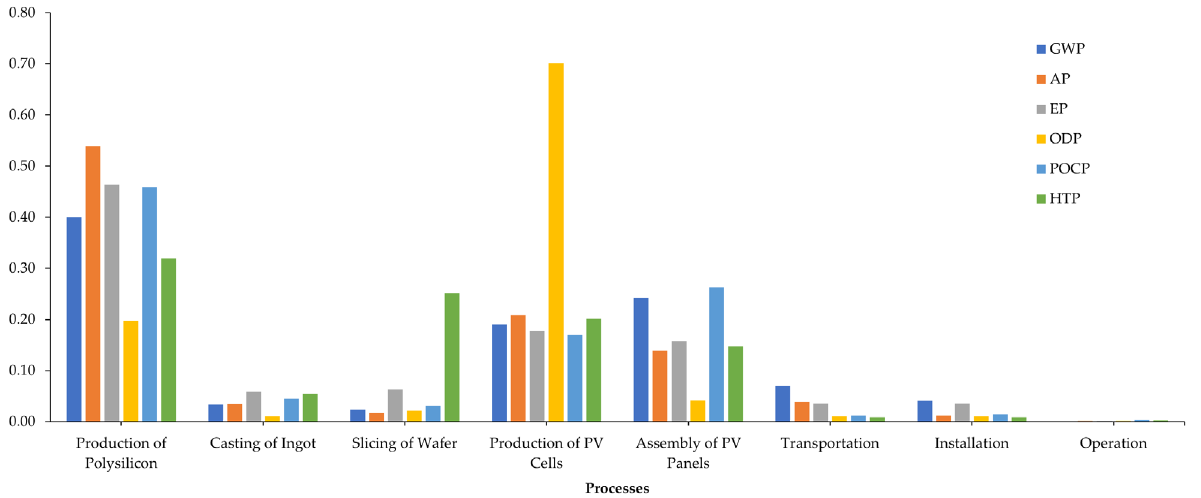
Figure 13. Normalized environmental impacts for all processes.